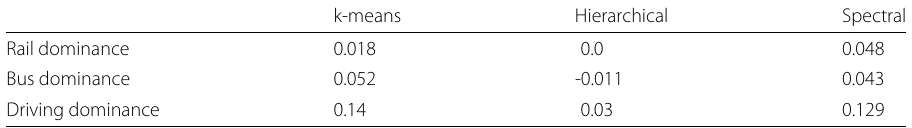
Table 9 The mutual information (AMI) between the groups created from the dominance scores and the groups created from the distances to the nearest node of the appropriate type k-means Hierarchical Spectral 0.018